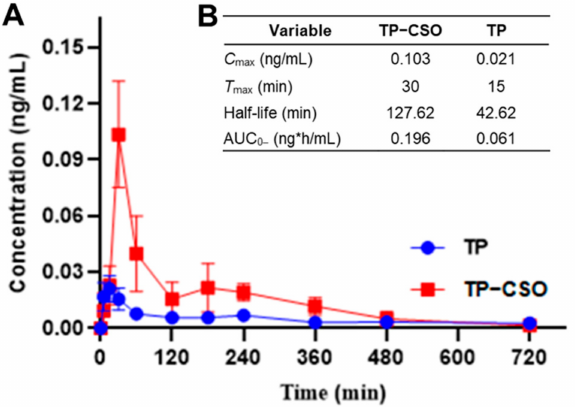
Figure 3. Plasma concentration of TP ( A ), pharmacokinetic parameters ( B ) after administration of TP and TP-CSO, respectively (n =